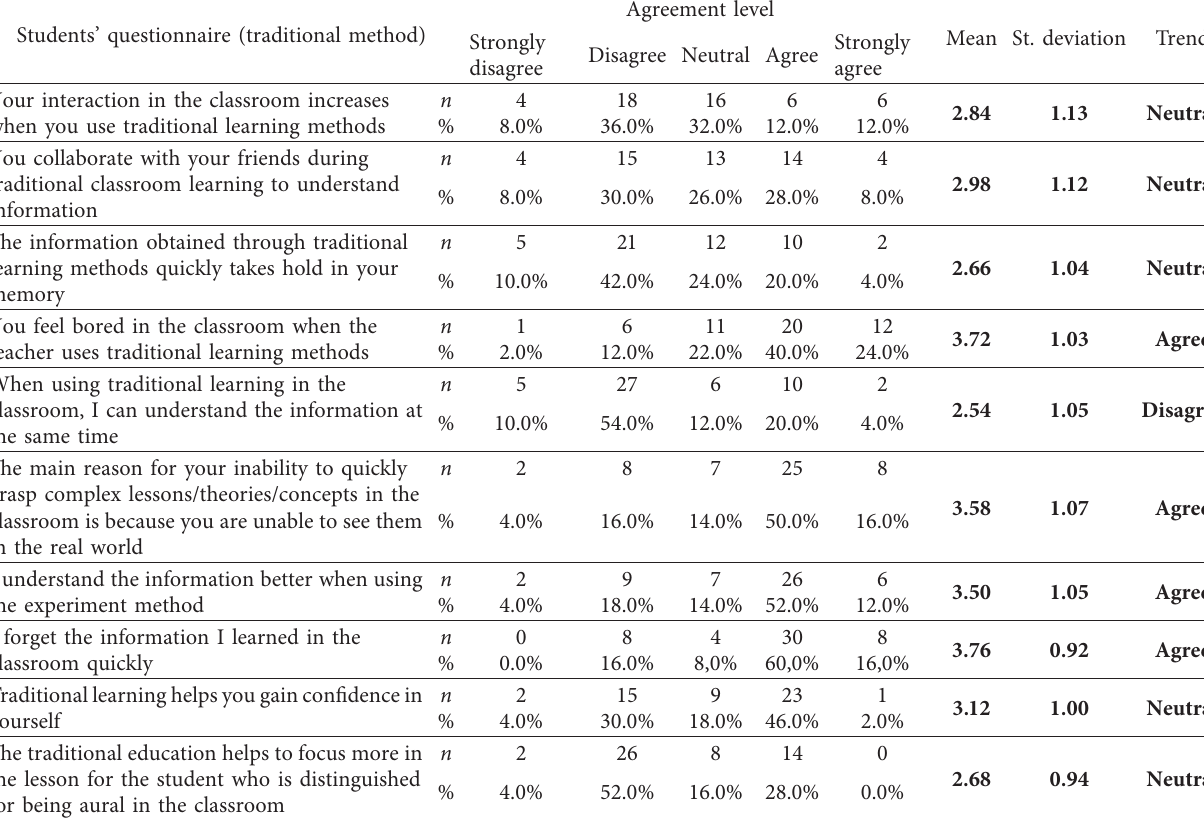
Table 8: Agreement level from the students concerned with the traditional method.